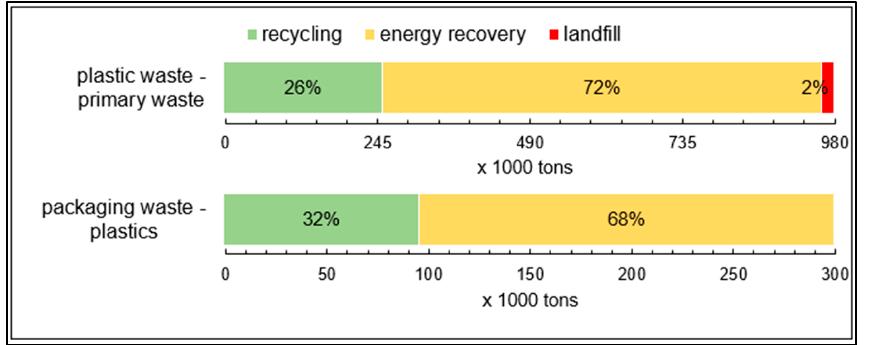
Figure 12. Treatment rates of primary plastic waste and plastic packaging waste in Austria in 2018, own illustration [22,25].